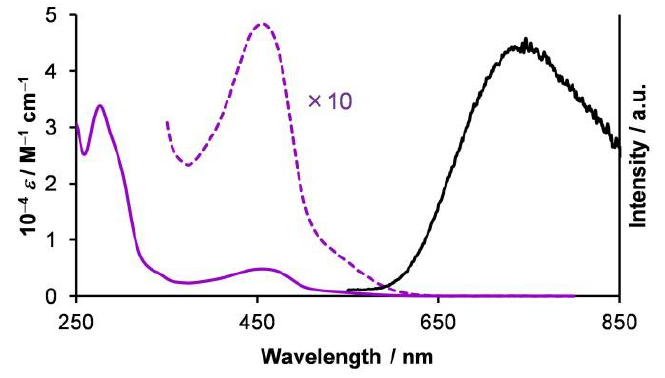
Figure 7. UV-vis spectra of 1  BF the dark (purple); absorption spectrum in the dark, ×10 (dashed purple); emission spectrum (black). Adapted with permission from [42]. Copyright (2012) American Chemical Society.